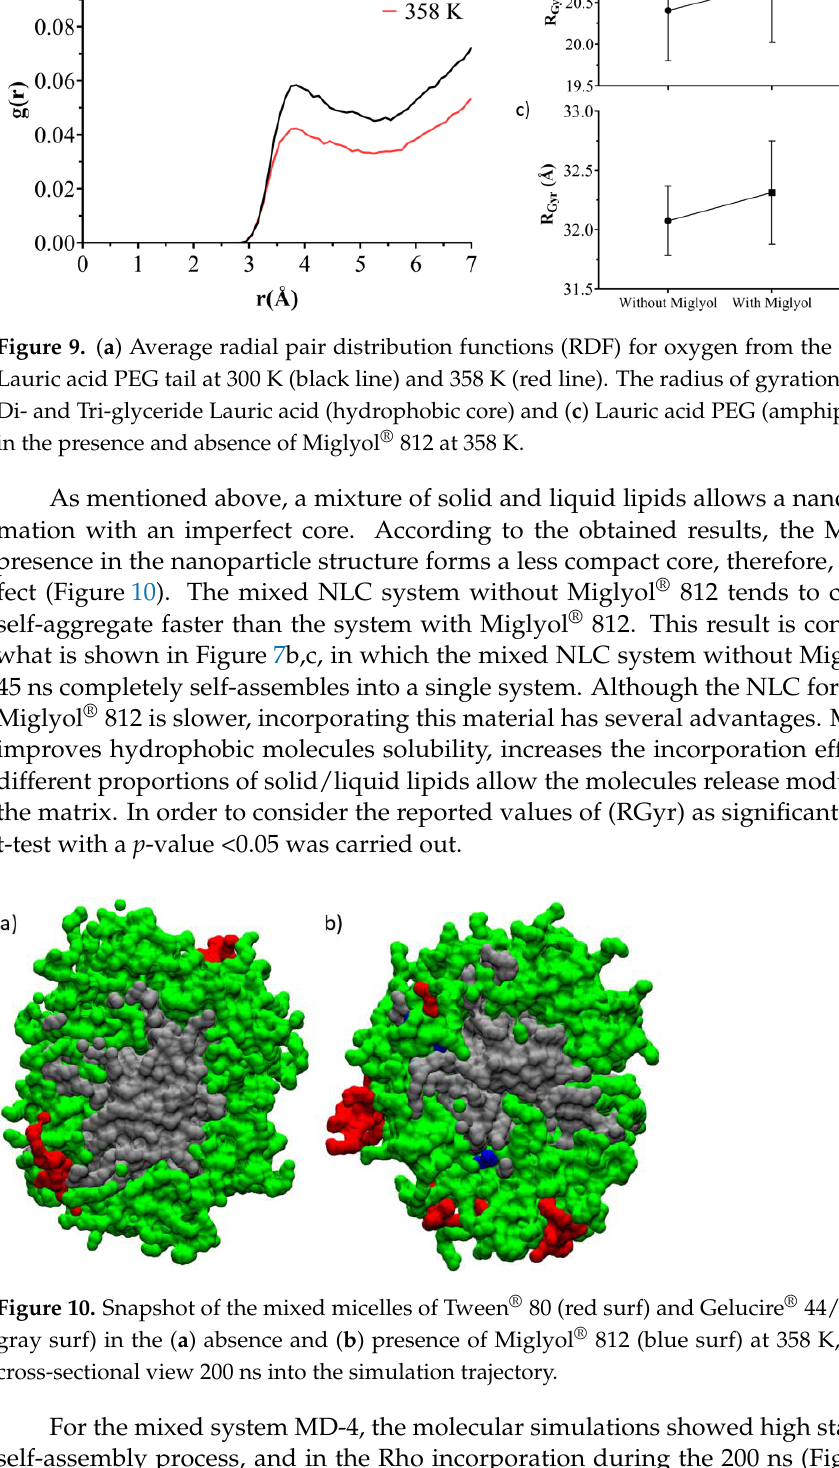
17 of 22 Figure 8. Solvent accessible surface area (SASA) as a function of simulation time for Mono-, Di- and Tri-glyceride Lauric acid at 300 K (black line) and 358 K (red line) during the self-association process. The radial density functions for the tail of lauric acid PEG and oxygen of water mol- ecules from the mixed NLC at a temperature of 300 K and 358 K show in Figure 9a greater interaction between lauric acid PEG tails with water molecules when the temperature is 300 K; this is due to the poor self-aggregation process to form a complete mixed NLC.